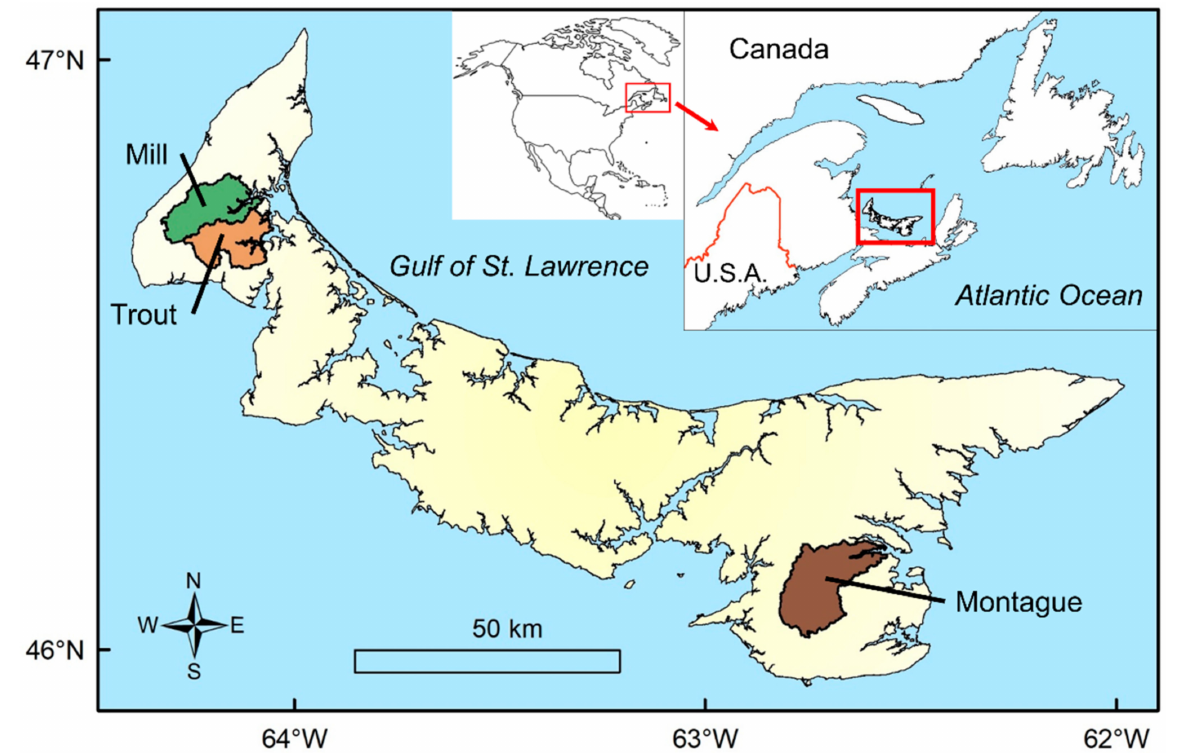
Figure 1. Map showing the location of Prince Edward Island, Canada, and the three study